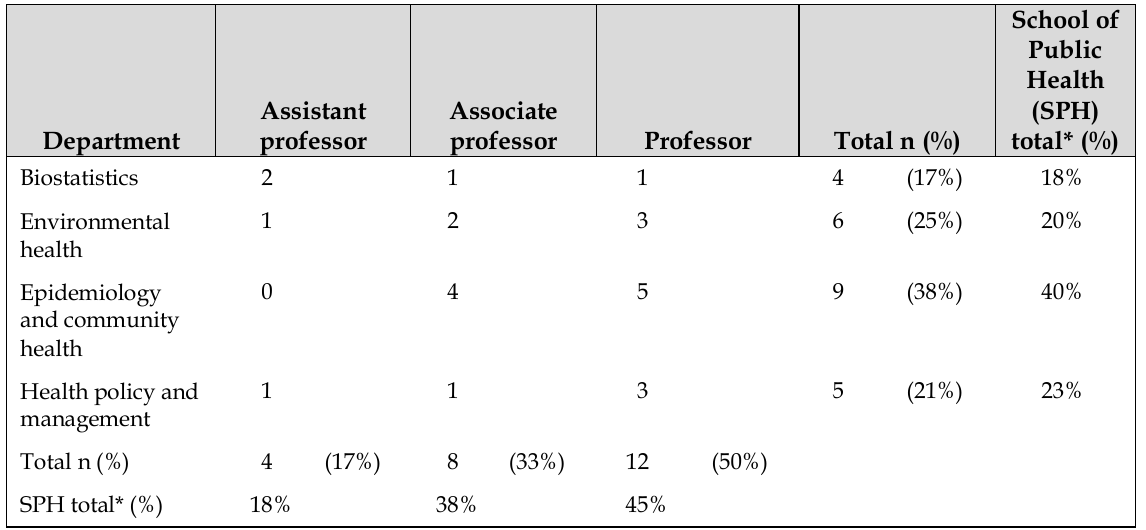
Table 1 Distribution of interview